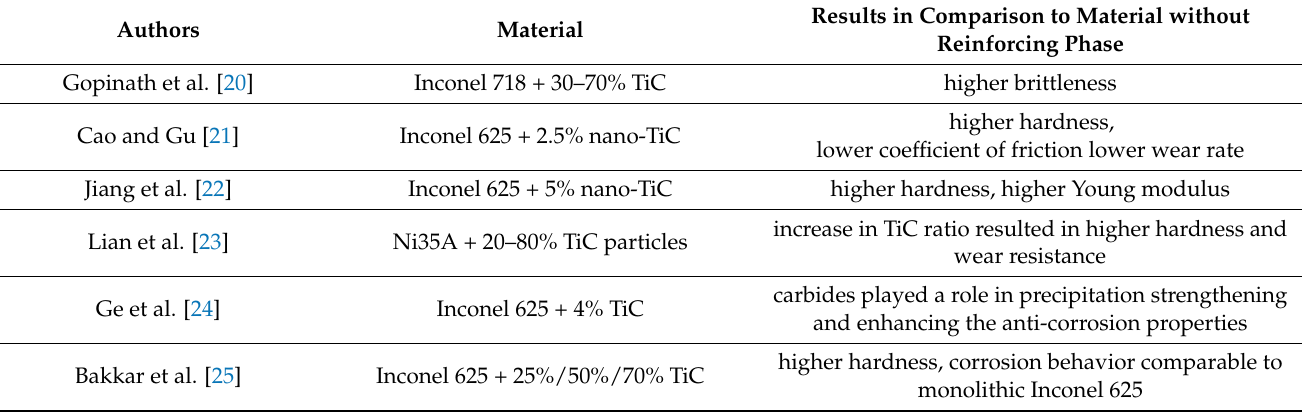
Table 1. Chemical compositions of S355JR substrate material and Metcoclad 625